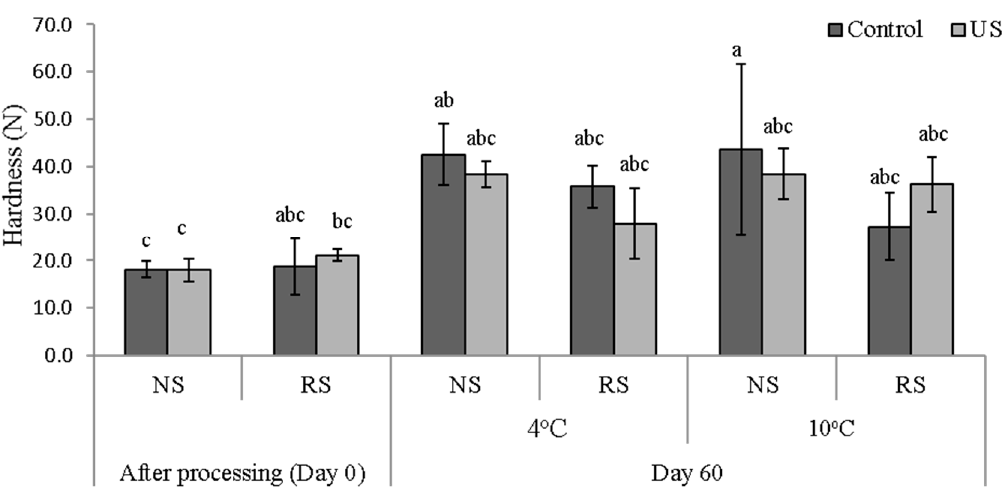
Figure 4. Hardness values of meat samples with standard sodium content (NS) or reduced sodium content (RS) at Day 0 and after 60 days storage at 4 and 10 °C. Values represent means ± standard deviation (SD, N = 3). Different letters are significantly different at p < 0.05.